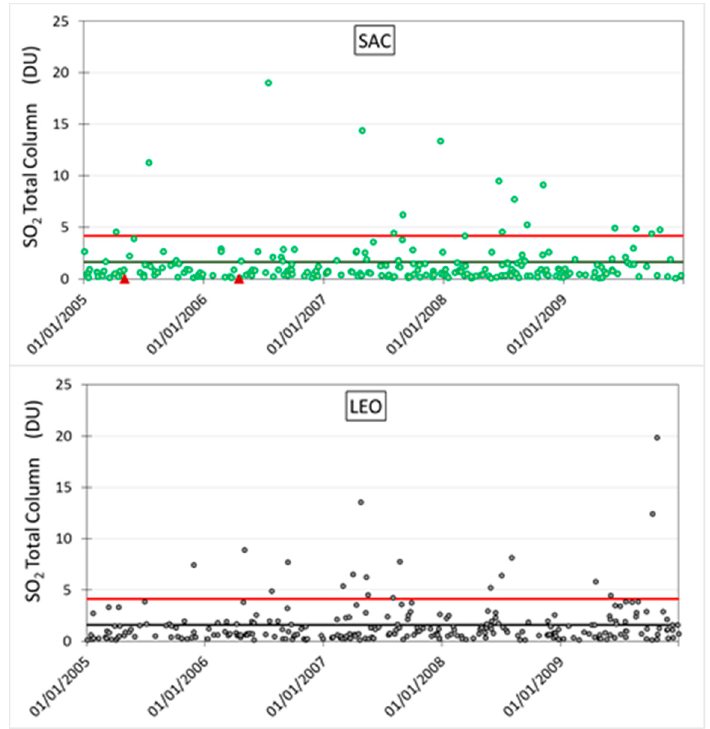
Figure 1. SO 2 total column time series (2005–2009 period) for SAC ( top ) and LEO ( bottom ) sites, measured with OMI instrument on Aura/NASA satellite. The mean values are also represented with horizontal lines at: SO 2 * OMI,SAC = 1.61 DU and SO 2 * OMI,LEO = 1.60 DU . The red lines correspond to the lower limit value for a significant event (see formula 1). Source: Goddard Space Flight Center/NASA